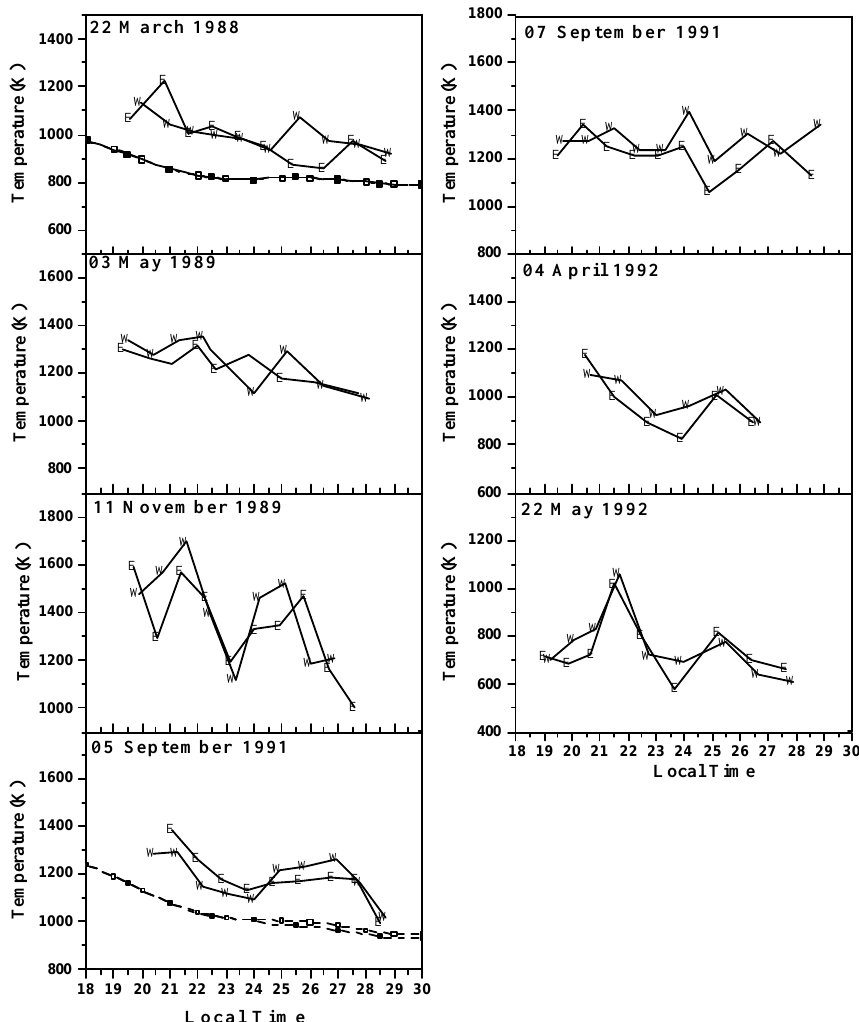
Fig. 2. Nighttime variations of the observed temperatures to the east and west, for representative nights without thermospheric zonal temperature gradi- ents. The temperatures obtained from the MSIS-90 model are also shown for two different longitudes (23 ◦ S, 41 ◦ W, closed square) and (23 ◦ S, 49 ◦ W, open circle) at 270km of